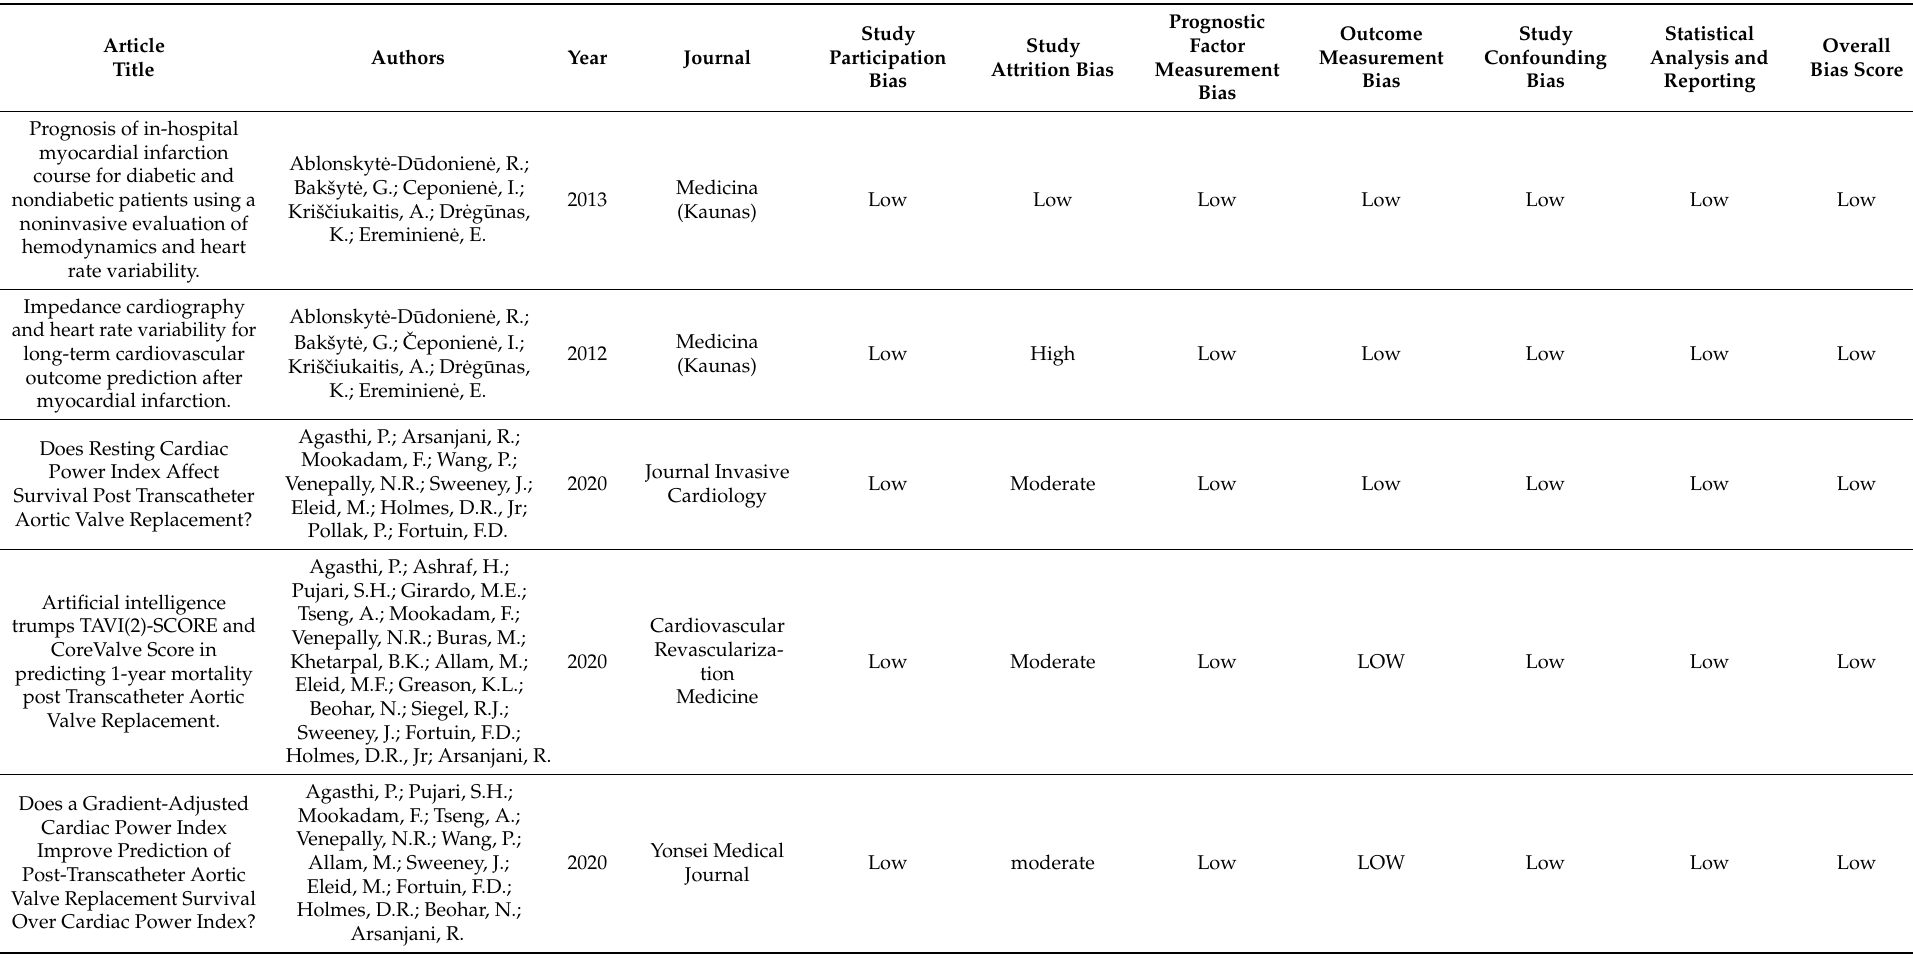
Table 2. QUIPS bias screening results